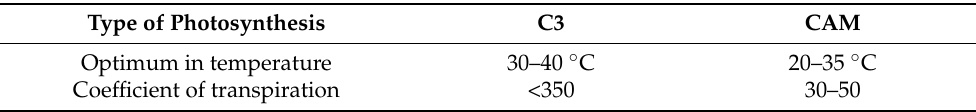
Table 1. Overview of the type of photosynthesis of C3 and CAM plants with differences in optimum in temperature and coefficient of transpiration (based on Weiler et al., 2008